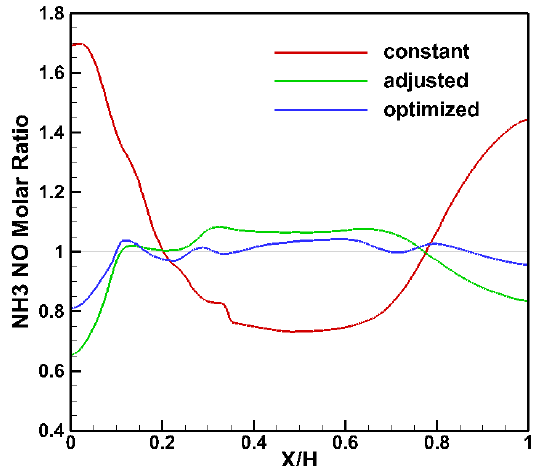
Figure 10. Comparison of NH 3 /NO ratio at the inlet of the catalyst layer for the parabolic profile.